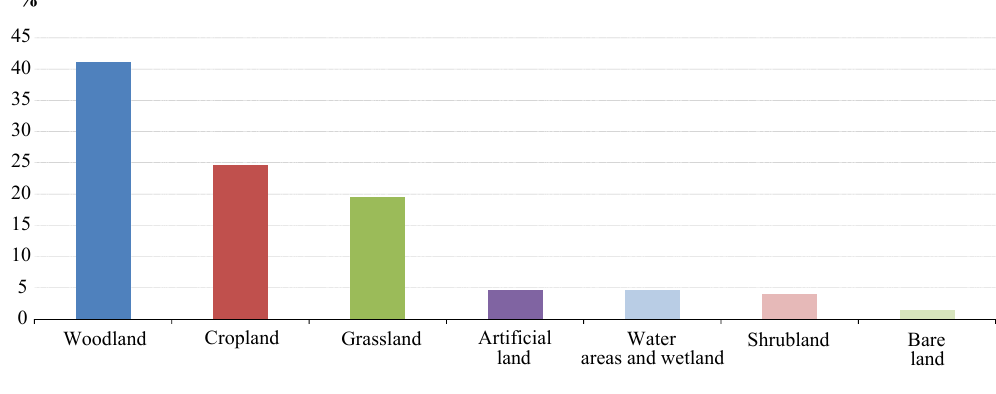
Fig. 1. Main land cover by land cover type, EU-27, 2012, % of total area (Eurostat,